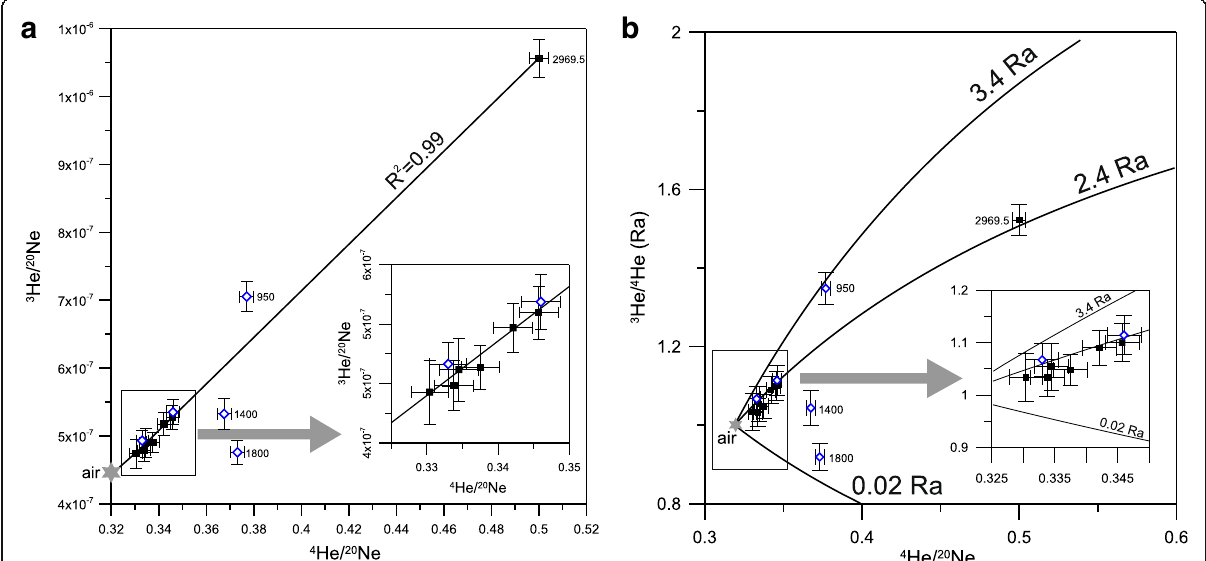
Fig. 3 3 He/ 20 Ne vs. 4 He/ 20 Ne ( a ) and 3 He/ 4 He vs. 4 He/ 20 Ne diagrams ( b ). In both diagrams, all samples from Exp 348 (black squares) and samples #1700 and #1850 from Exp 338 (blue open diamonds) plot on a mixing line between air and a mantle-derived fluid with 3 He/ 4 He composition of 2.40 ± 0.10 Ra (see text). Hyperbolic lines on diagram b indicates mixing between air and different reservoir endmembers with 4 He/ 20 Ne = 1000 and 3 He/ 4 He = 0.02 (crustal), 2.4 and 3.4, respectively. Numbers denote sample